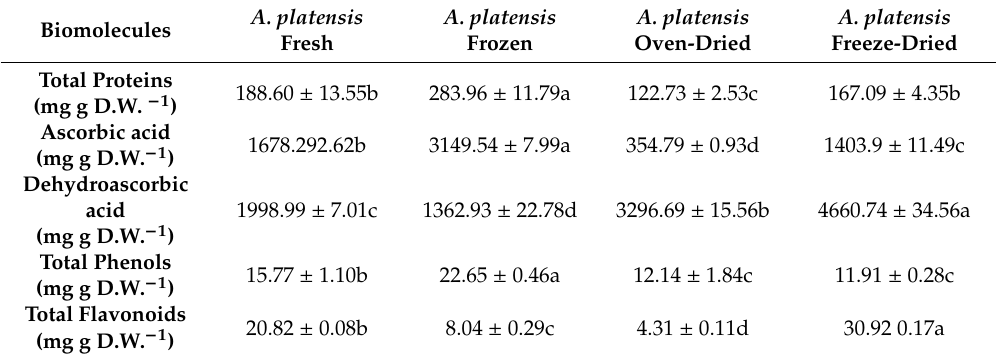
The total proteins and antioxidant molecules in A. platensis biomass fresh and di ff erently